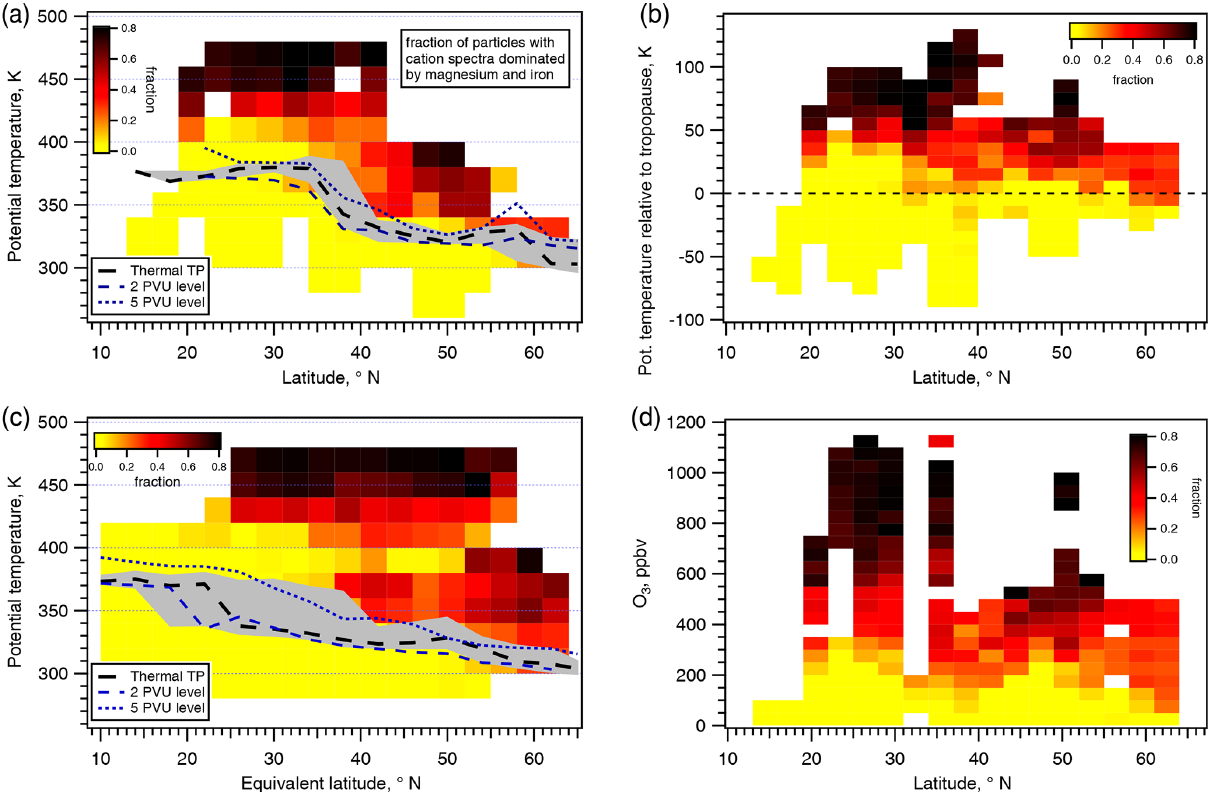
Figure 4. Fractional abundance of particles with cation mass spectra dominated by magnesium and iron ions as a function of potential temperature and latitude (a) , as a function of distance to the tropopause and latitude (b) , as a function of potential temperature and equivalent latitude (c) , and as a function of ozone and latitude (d) . The data of all five UTLS aircraft missions have been merged for this figure (in total 338354 analysed particles). Also shown in (a) and (c) is the median thermal tropopause (from ECMWF; TP) along with interquartile range (grey shading) and two dynamical tropopause levels (2 and